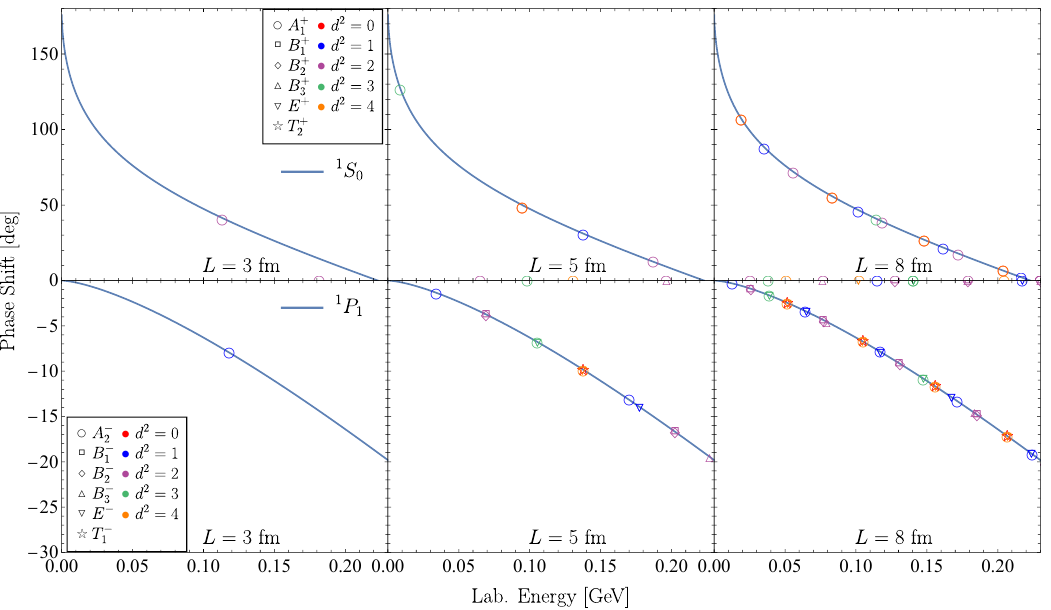
Figure 3 . Upper (lower) row: various symbols show the 1 S 0 ( 1 P 1 ) phase shifts calculated from the FV energy spectra using the single-channel Lüscher formula for the case of pionless EFT at NLO. Only those energy levels were used which belong to the irreps with the 1 S 0 or 1 P 1 components. Solid lines are the corresponding phase shifts calculated in the infinite volume. Left, middle and right graphs show the results obtained in the FV boxes with L = 3 , 5 and 8 fm, in order.